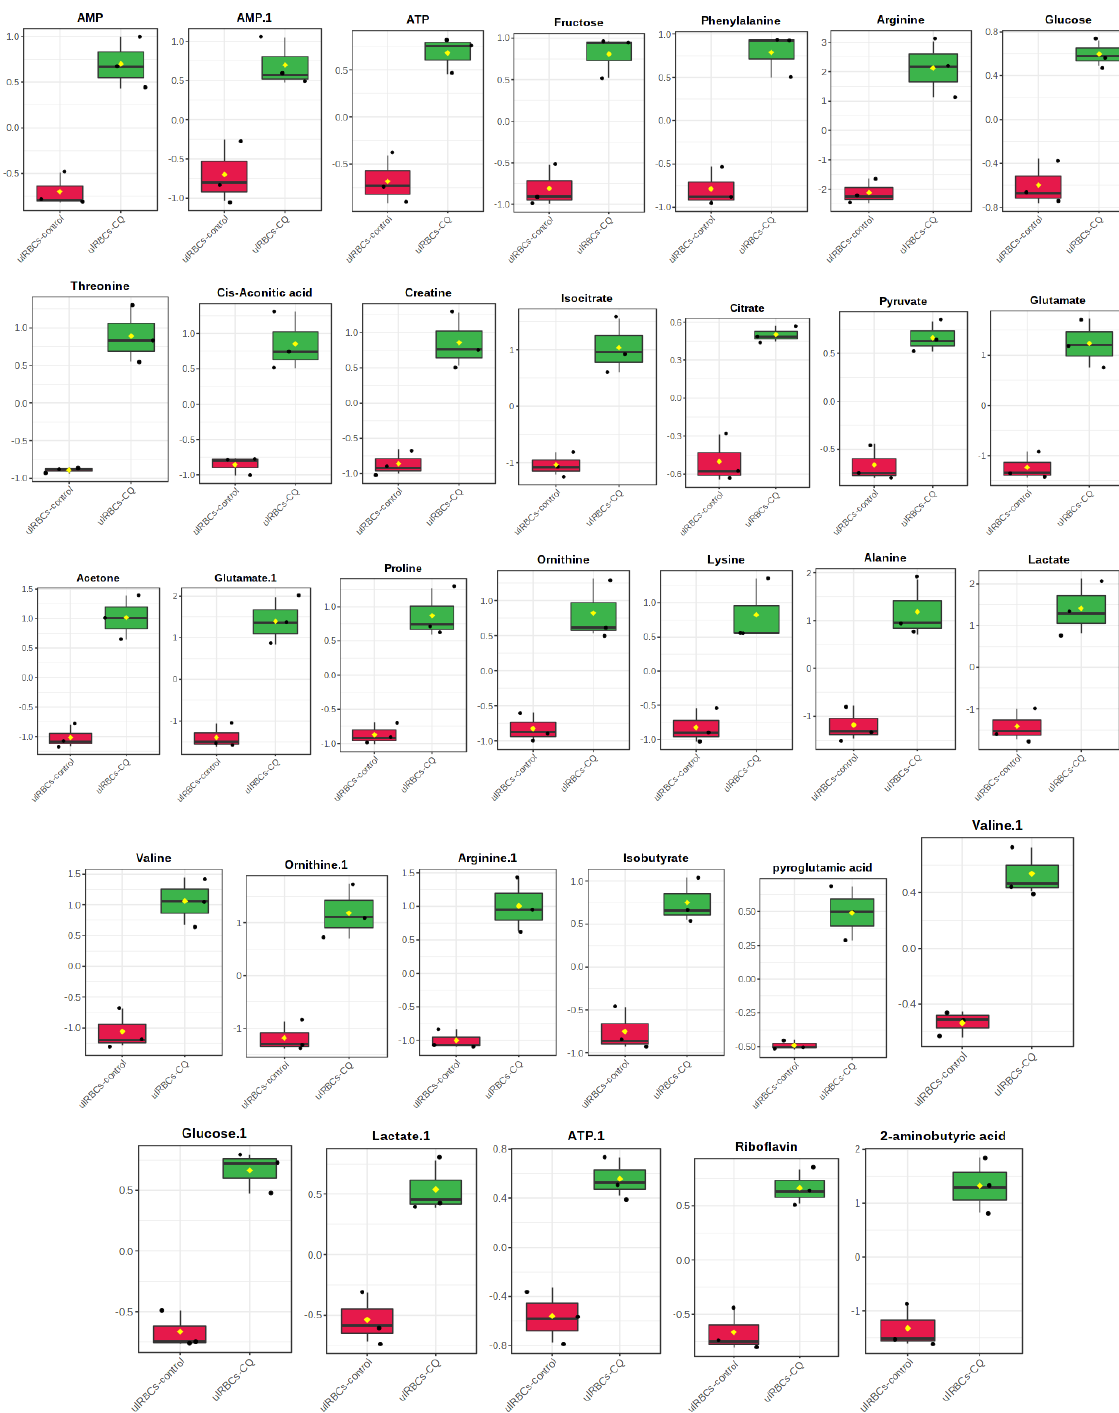
Figure 12. Box plots of the relative quantities of the significant metabolites of uRBCs-CQ (green color) and uRBCs (red color) using 1 H-NMR spectra binned data with VIP value ≥ 0.1 in OPLS-DA model. uRBCs, uninfected red blood cells; CQ, chloroquine.